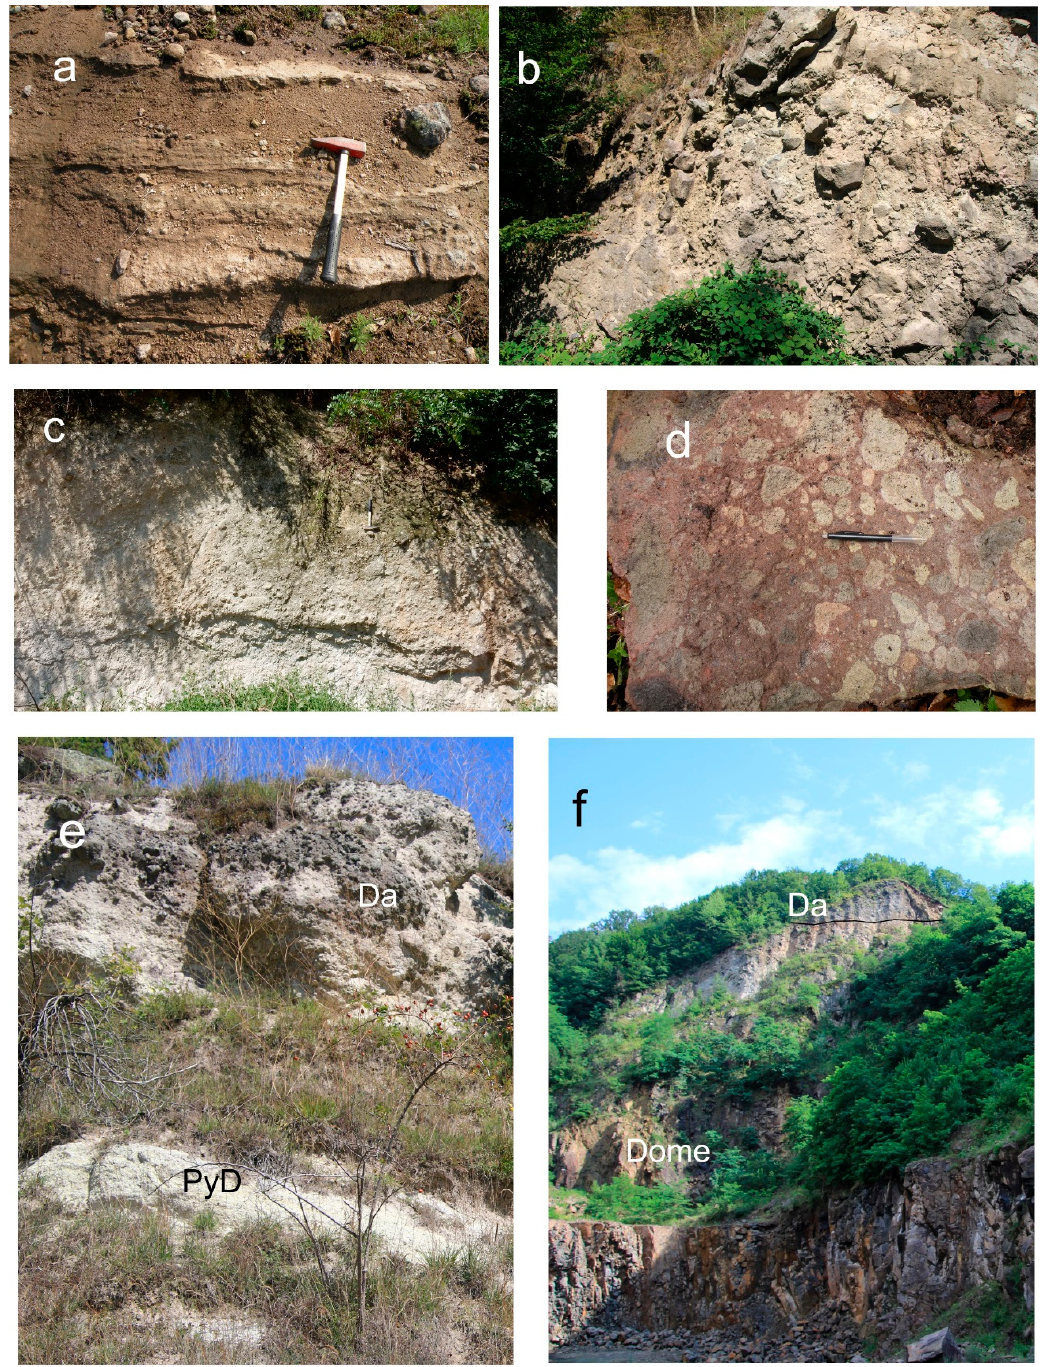
Figure 7. ( a ) Hyperconcentrated flows and fluvial deposits showing thin and cross-bedded sandstone showing of alternating coarse and fine layers with discontinuous lapilli trains, some with low angle cross laminations—WDA; ( b ) Matrix facies DAD including various size larger angular clasts –EDA; ( c ) Several meter thick pumiceous pyroclastic flow deposit showing cm-dm size pumice clasts—EDA ( d ) Cm-dm size juvenile pumice (brighter) and scoria (darker) clasts embedded in an ash-matrix characterizing a pyroclastic block and ash flow deposit—EDA; ( e ) Several meter thick pumiceous pyroclastic flow deposit (PyD) that in its upper part is mingled with debris avalanche breccia (DA) showing a contorted plastic shape—SDA; ( f ) Debris avalanche deposits (DA) situated at the top of the Vârfuri lava Dome–NDA.